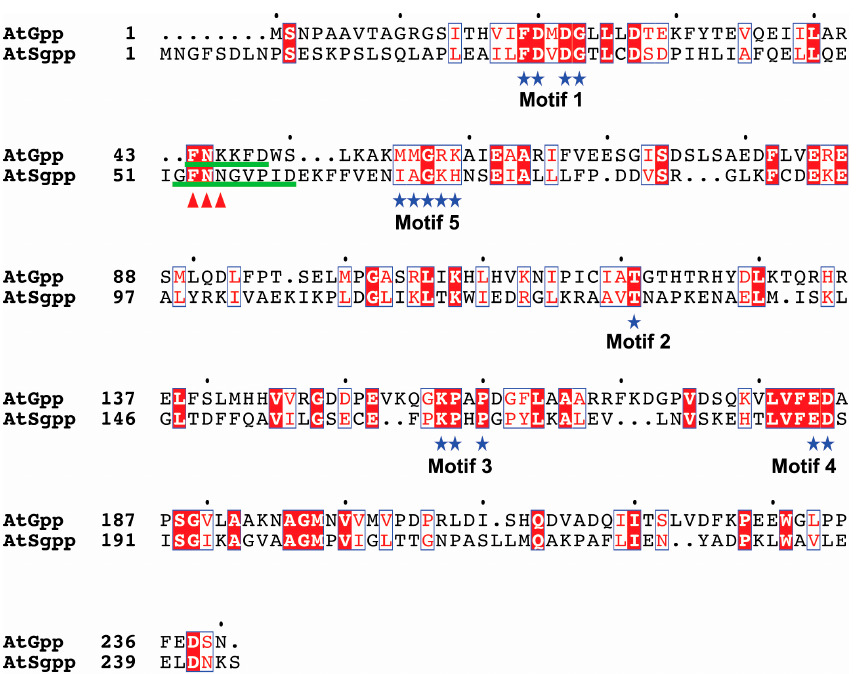
Figure 1. Comparison of the global structure arrangement of the Arabidopsis AtSgpp and AtGpp proteins. Conserved amino acids are shown in red on white background. Identical amino acids are depicted in white on red background. The residues contained in the structural elements are indicated with a blue star. Residues in the cap module taking part of the active site, the boundaries of the cap sequence region defined by motifs 1 and 2, and the conserved Gly (G) that identifies the motif 5 motif within this segment, were derived from the information of the predicted 3D models. The loop preceding the motif-5 is underlined in green. The deleted residues in AtSgpp are marked with red arrowheads. This figure was generated using ESPript [37]. Table 1. Kinetic parameter k cat , K m , and k cat / K m of the phosphatase activity of purified AtSgpp and deletion mutant protein AtSgpp- ∆ F53N54N55 (AtSgpp3 ∆ ) on various organic phosphomonoesters. phosphomonoesters) and 25 µ g / mL of the purified protein. Reaction temperature: 32 ◦ C. Data